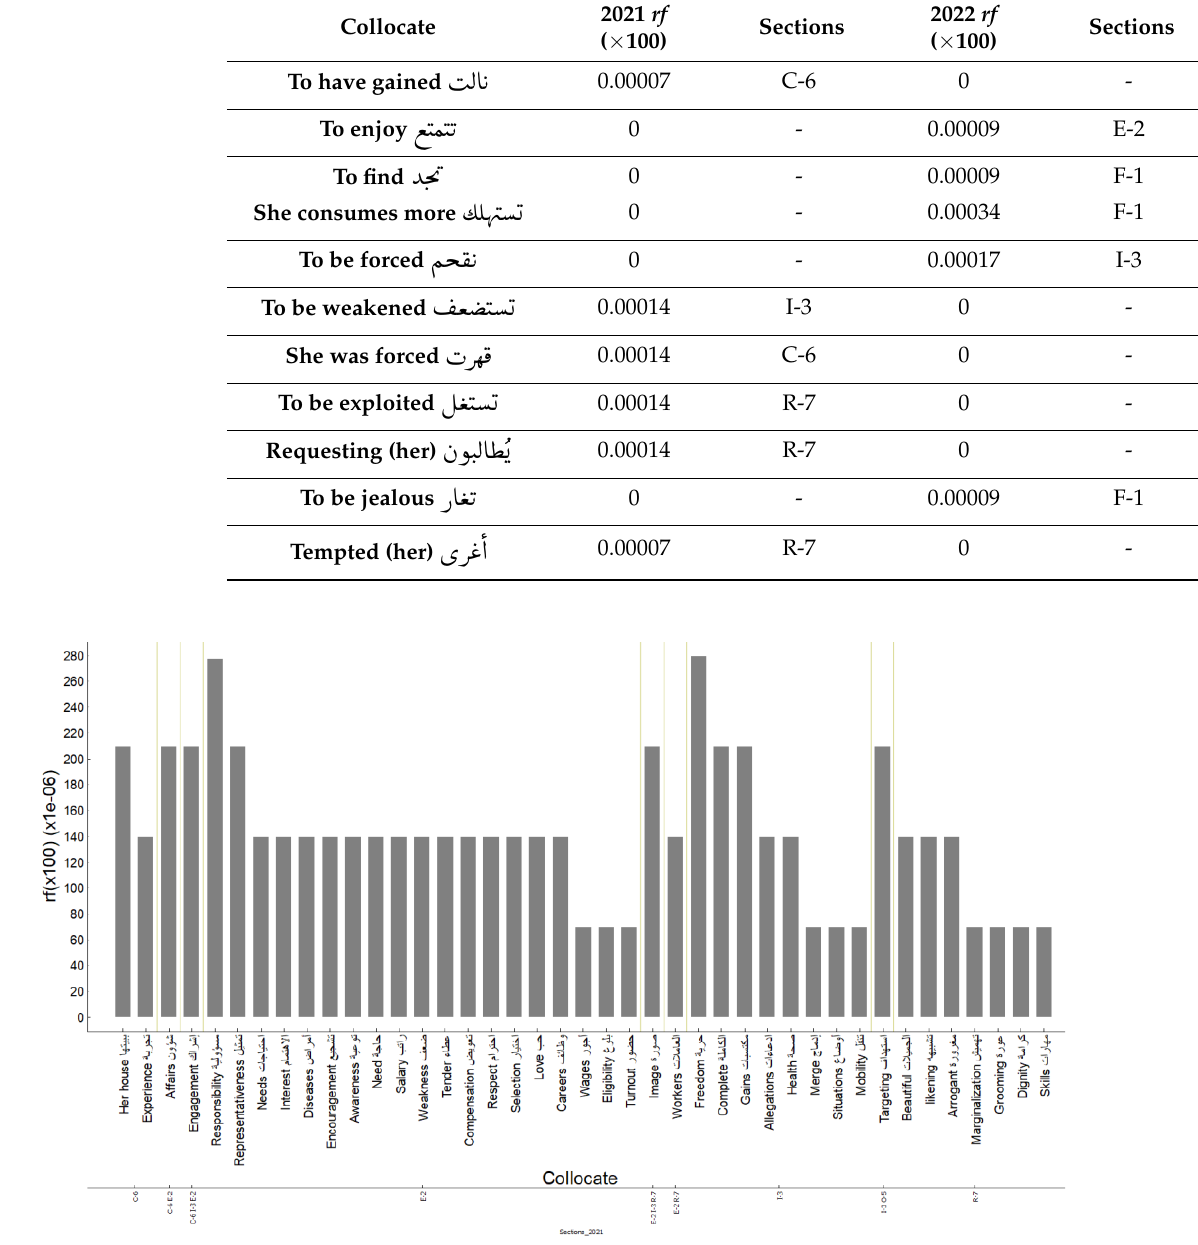
Figure 2. Bar plot of the genitive/adjective construction co-occurrences rf = (>0.000001 × 100) for 2021.